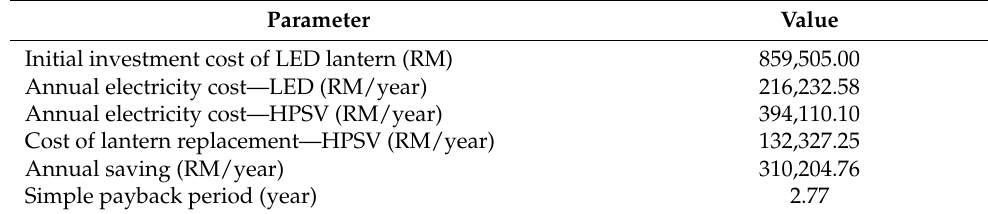
Table 5. Investment cost of LED